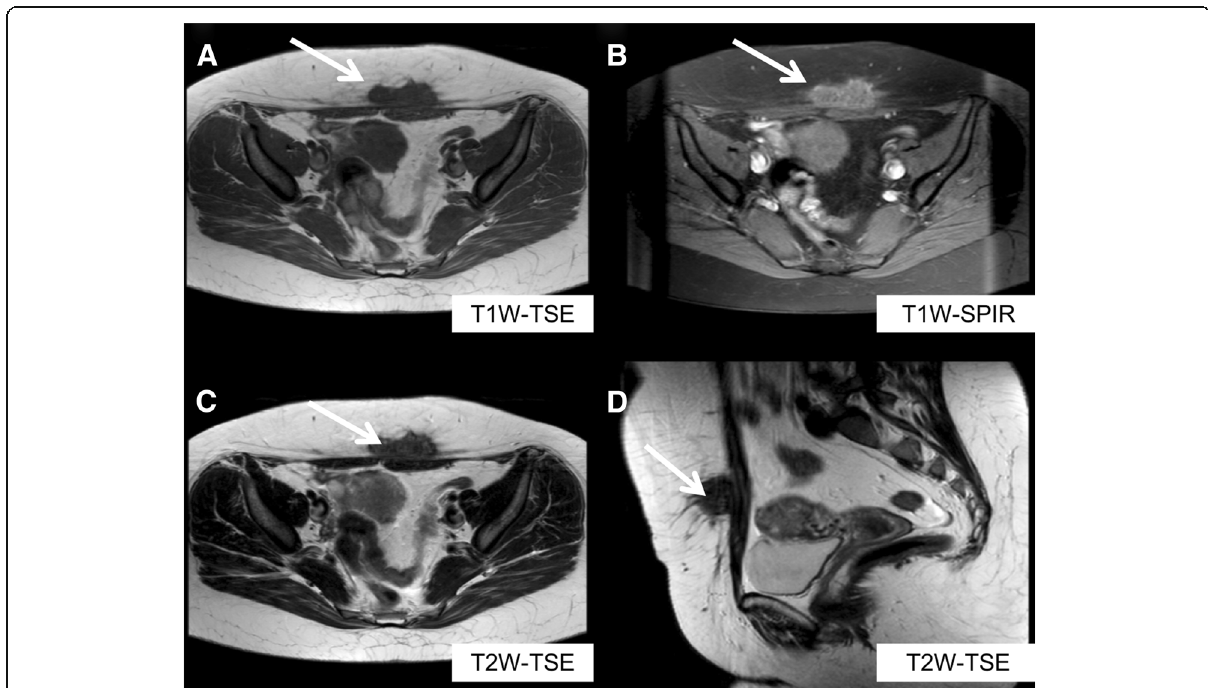
Fig. 11 Abdominal wall endometriosis: this is a case of a women with abdominal wall palpable mass within incisions after cesarean delivery. MR imaging showed a solid nodule (white arrow) with low signal both on T1-TSE-WI ( a ) and T2-TSE-WI (axial, c and sagittal sections, d ) with an iso- hyperintense signal on T1-SPIR WI ( b )